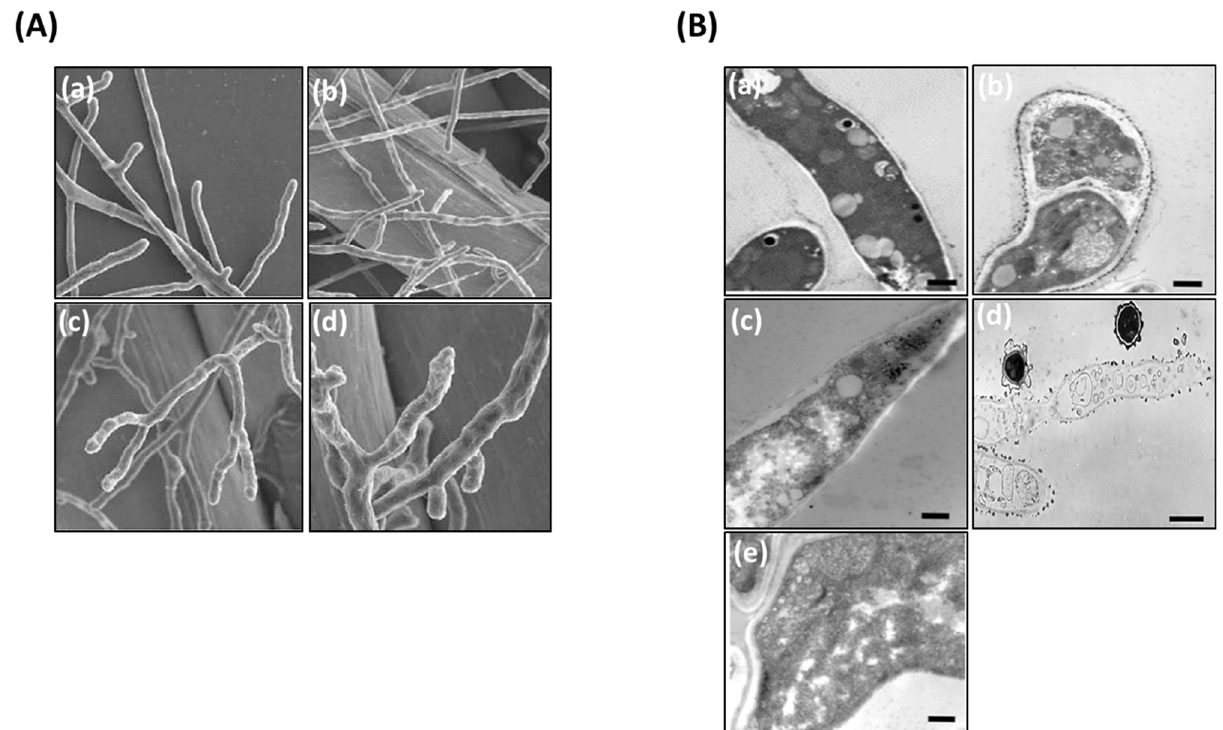
Figure 4. Electron microscopy photographs of A. fumigatus after treatment with AS-AgNPs. ( A ) Scanning electron micrographs of A. fumigatus treated with ( a , b ) saline and ( c , d ) AS-AgNPs (128 µg/mL). ( B ) Transmission electron microscopy of A. fumigatus biofilm treated with ( a , b ) saline and ( c – e ) AS-AgNPs (12,000× original magnification, bar = 600 nm).